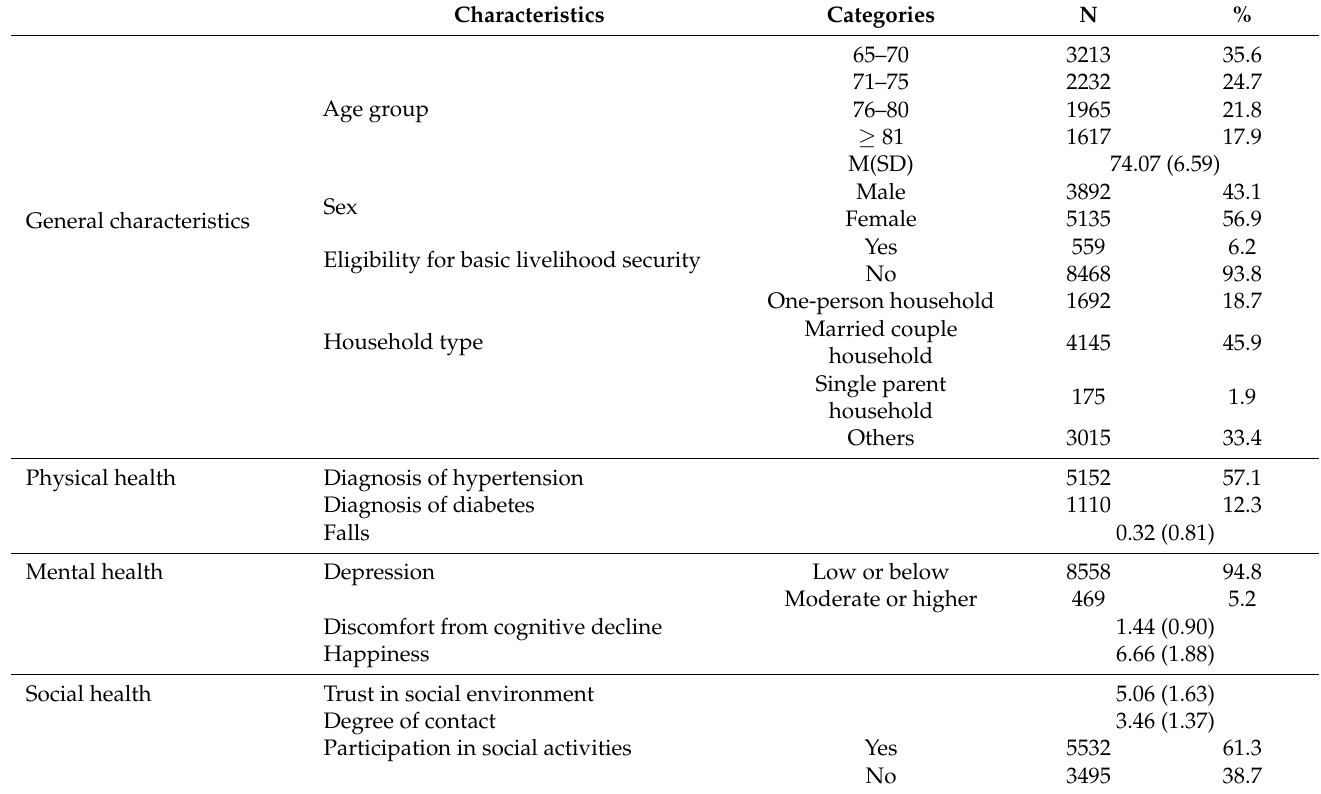
Table 1. Participants’ characteristics.